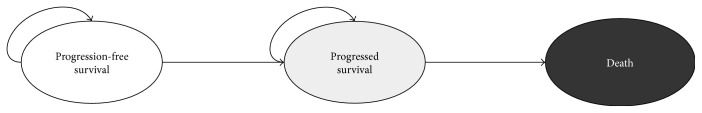
Simplified model structure based on the Markov process illustrating the two strategies for treating metastatic gastric cancer.